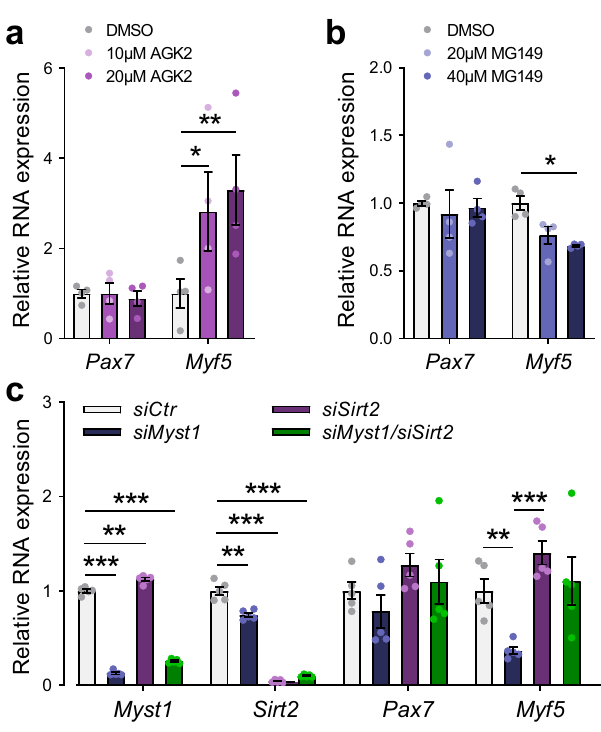
Fig. 3 MYST1 and SIRT2 control the expression of PAX7 target genes. a , b Expression level of Pax7 and Myf5 in primary myoblasts after treatment for 24 h with a the SIRT2 inhibitor AGK2 (10 and 20 μ M) or b the MYST1 inhibitor MG149 (20 and 40 μ M), as indicated. Gene expression was determined by RT-qPCR (normalized to Rps18 expression). Data are presented as mean values ± SEM ( n = 6 biologically independent samples) (Two-way ANOVA uncorrected Fisher ’ s LSD test: * p = 0.021 in ( a ); ** p = 0.0052 in ( a ) * p = 0.018 in ( b )). c Expression level of Myst1 , Sirt2 , Pax7 , and Myf5 in primary myoblasts after transfection with siRNA against Myst1 or Sirt2 , as indicated. Gene expression was determined by RT-qPCR (normalized to Rps18 expression). Data are presented as mean values ± SEM ( n = 6 biologically independent samples) (Two-way ANOVA uncorrected Fisher ’ s LSD test: *** p < 0.0001 siMyst1 ( Myst1 ); ** p = 0.0015 siSirt2 ( Myst1 ); *** p < 0.0001 siMyst1/siSirt2 ( Myst1 ); ** p = 0.0023